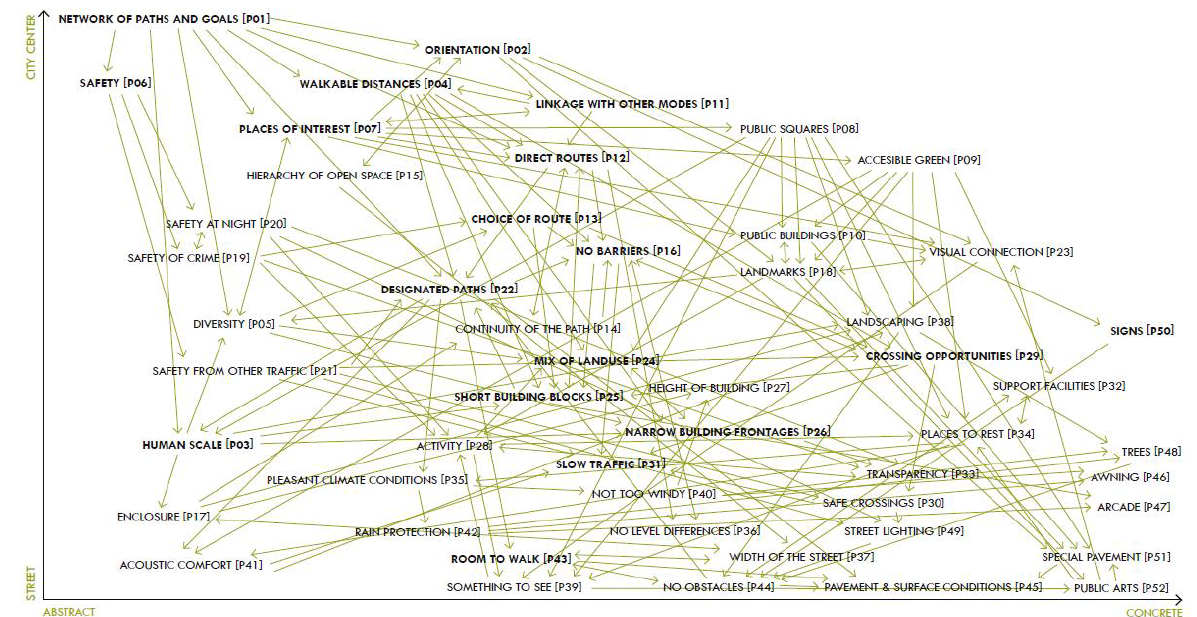
Figure 2. Example of a pattern field (van Bellen, 2010b, p.